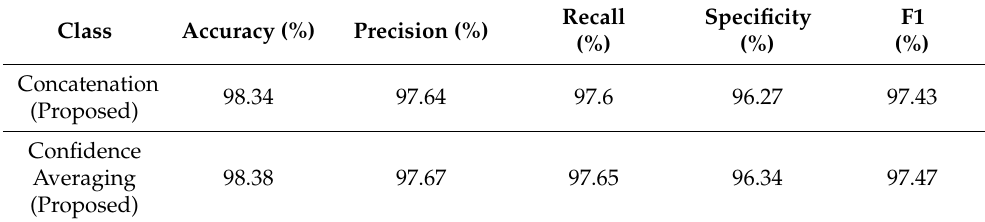
Table 6. Evaluation metrics using different ensemble learning